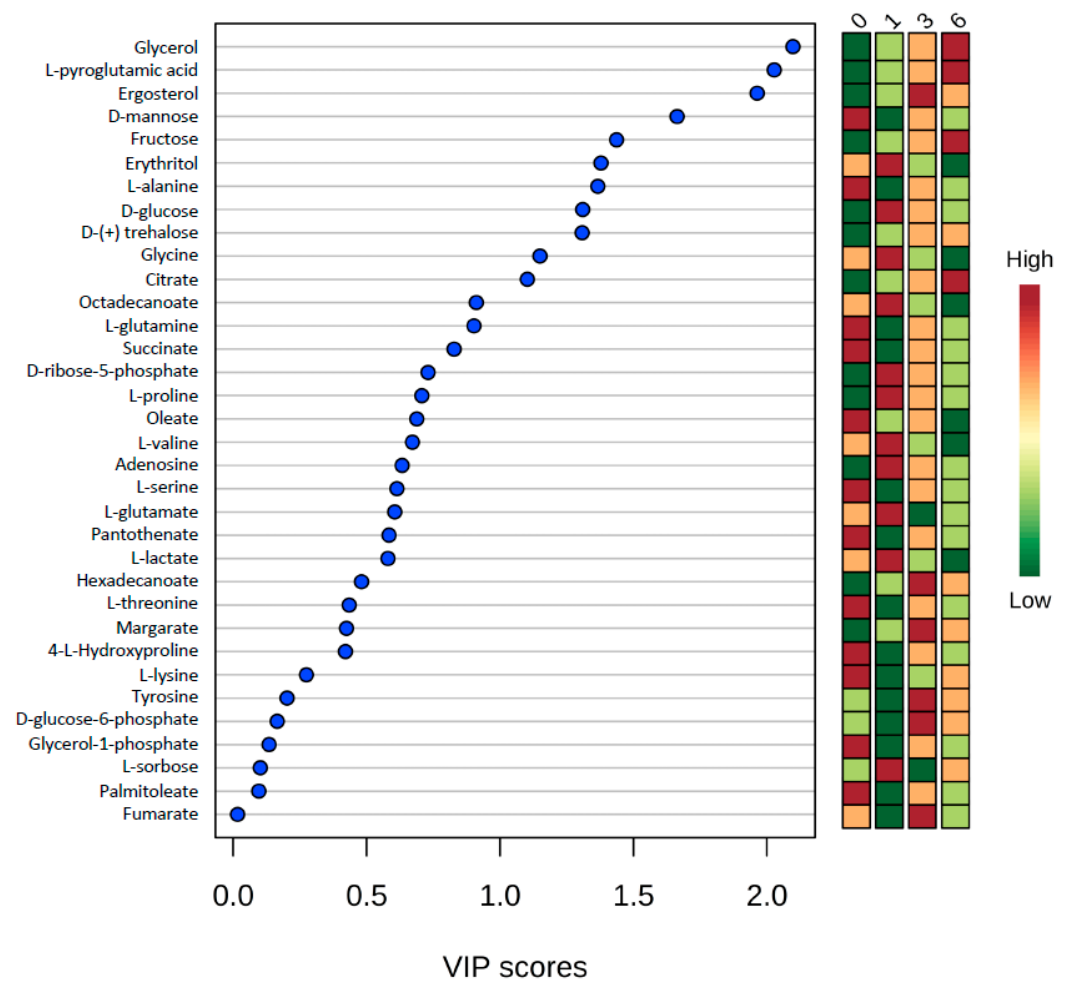
Figure 2. VIP score chart of all metabolites where VIP is Variable Importance in Projection, calculated as the weighted sum of squares of the PLS loadings taking into account the amount of explained Y-variation, in each dimension. The heatmap on the right represents concentration of metabolites at the time points where 0 = day 0, 1= day 1, 3 = day 3, 6 = day 6.